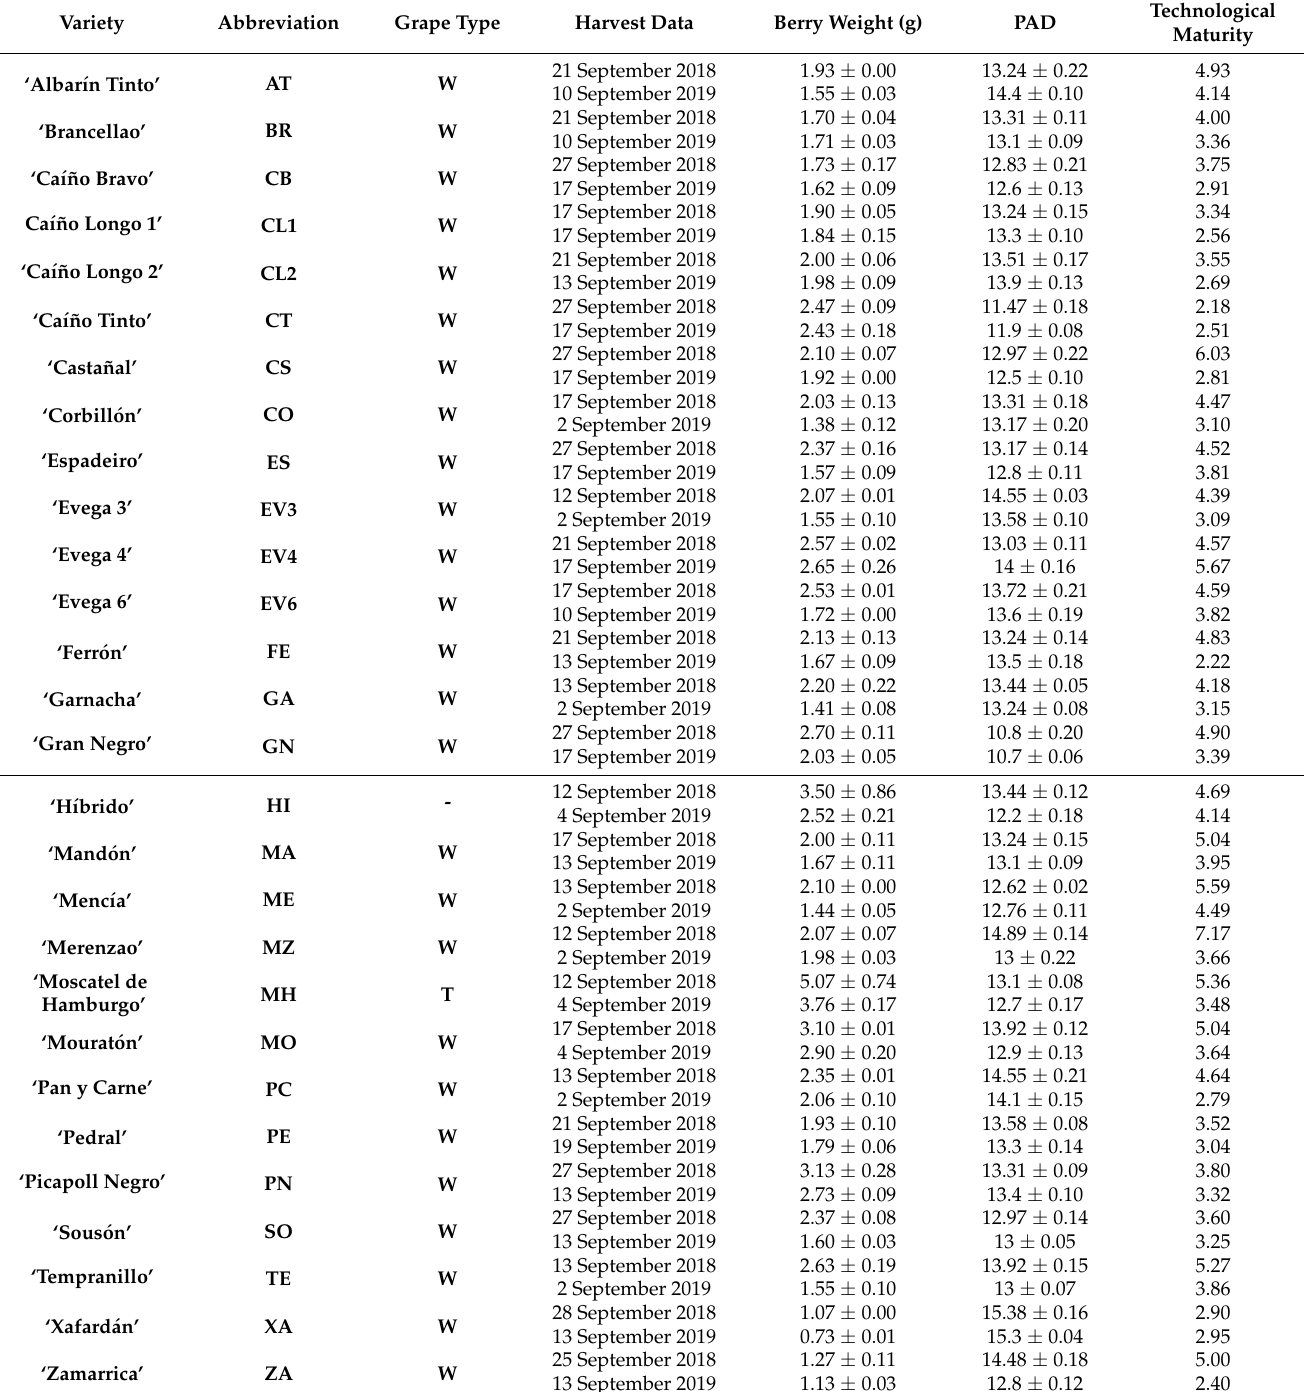
Table 1. Data of harvest, berry weight, and composition of grapes from the EVEGA germplasm bank in 2018 and 2019